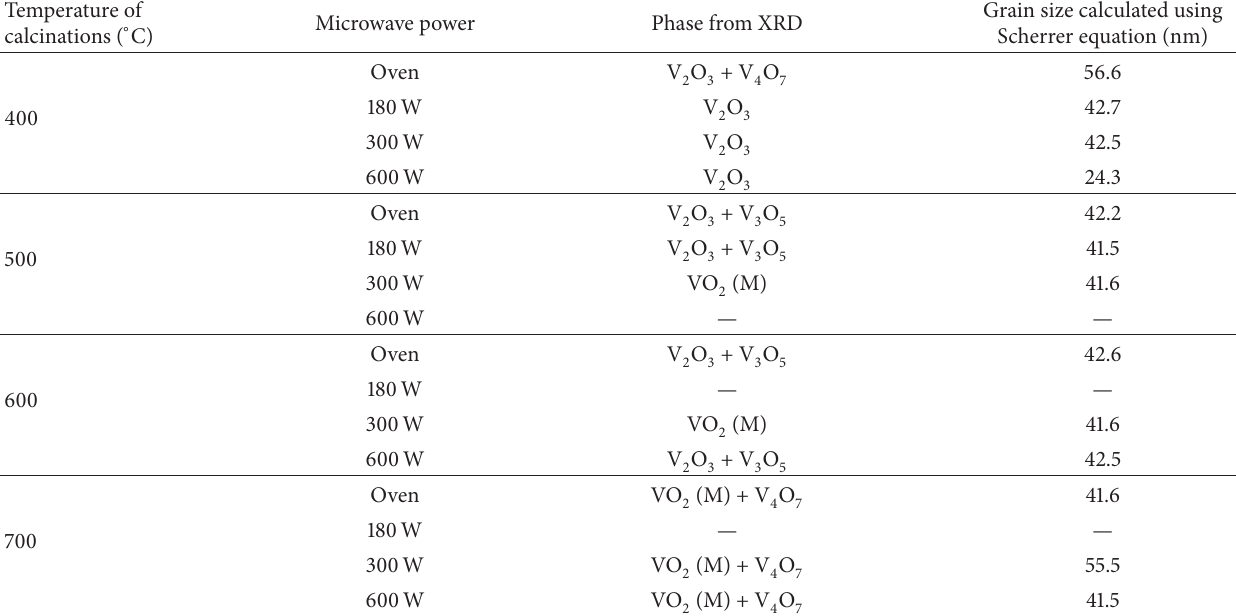
Table 1: Summary of grain size and phases of vanadium oxides after calcinations of the microwave assisted samples at different temperatures. Temperature of